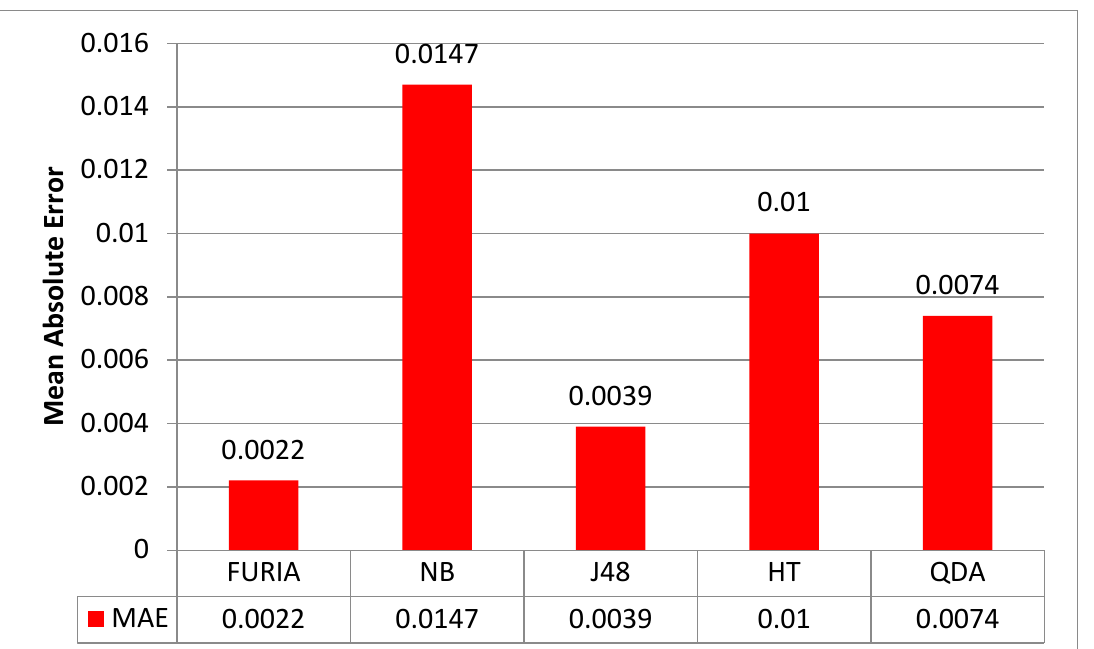
Figure 4. Proposed model comparison based on MAE.